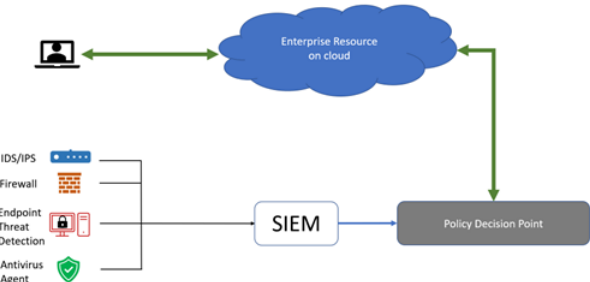
Figure 3. Policy evaluation process for cloud-hosted enterprise resource.